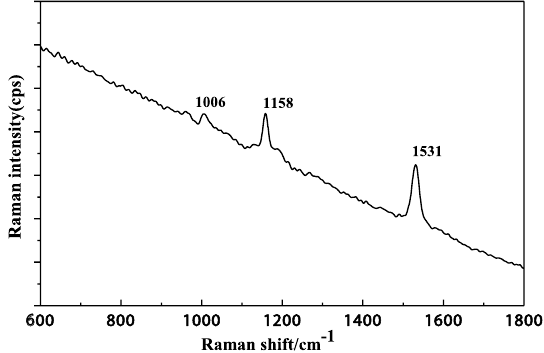
Fig. 3. Raman spectra of orange fruit.